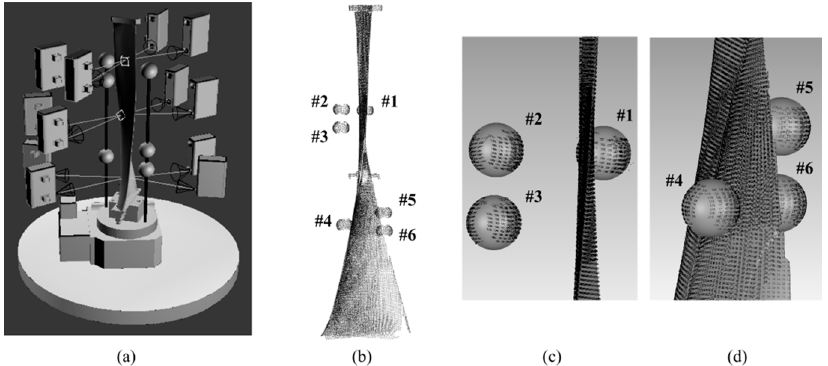
Figure 11. Registration of a turbine blade, ( a ) multiple measurement perspectives for the blade; ( b ) point cloud of blade after registration; ( c ) registration result of the upper segment; and ( d ) registration result of the bottom segment.